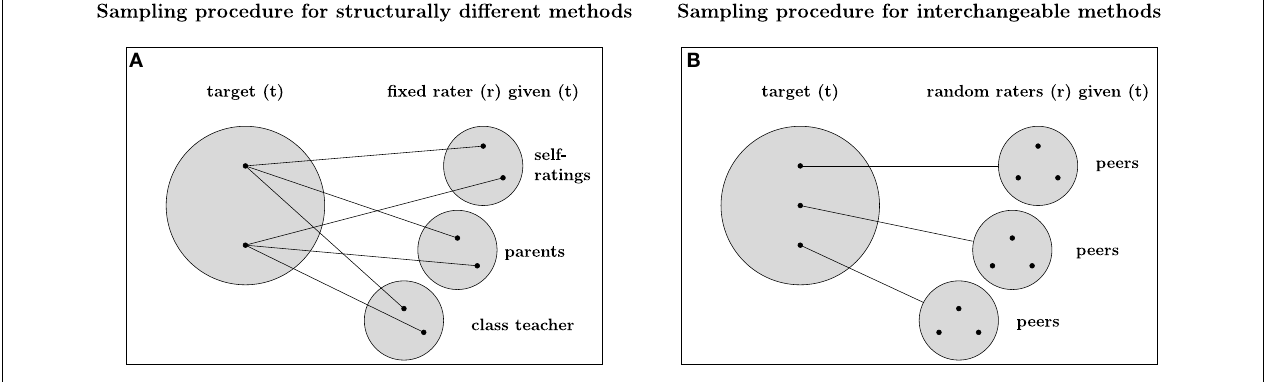
FIGURE 3 | Sampling procedure for different types of methods. Panel (A) refers to the sampling procedure of measurement designs with structurally different methods. Panel B refers to the sampling procedure of measurement designs with interchangeable methods. The big gray filled circles are the sets of possible targets, the small gray filled circles are the sets of possible